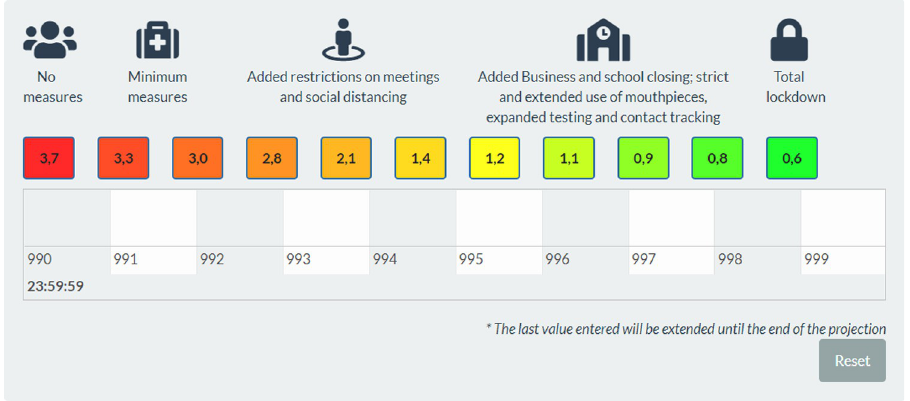
Fig 2. Traffic light of political interventions associated to R0